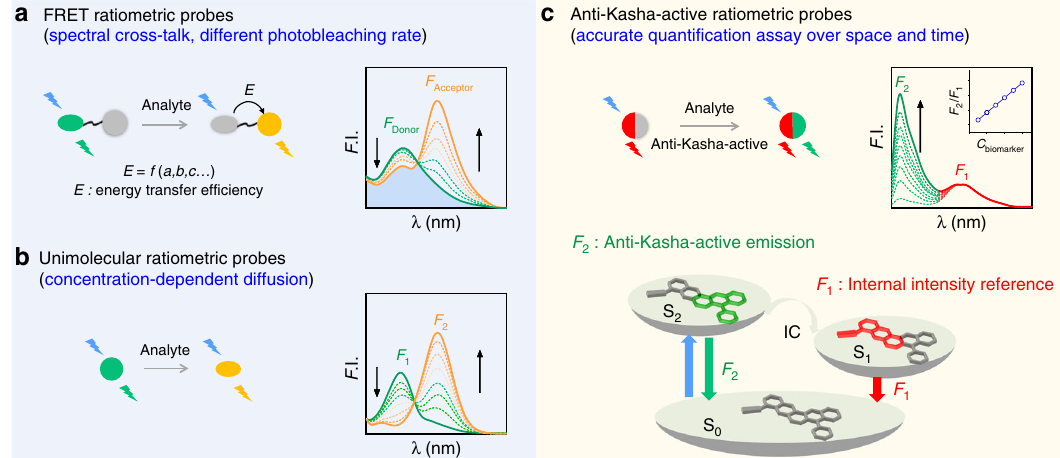
Fig. 1 Strategies for ratiometric probes with characteristic analysis. a FRET ratiometric probes: excitation/emission cross-talk. b Unimolecular ratiometric probes: different photobleaching rates and concentration-dependent diffusion between reactant and product fl uorophores in dynamic cellular environment. c In this work, anti-Kasha-active ratiometric probes enabling accurate and reliable ratiometric quanti fi cation: an invariant NIR emission from the Kasha- based S 1 state serve as an internal reference; a green emission from the anti-Kasha-active S 2 state linearly increase with the concentration of targeted analyte, due to the rapid radiative process from S 2 to S 0 state, competing with the internal conversion (IC) from S 2 to S 1